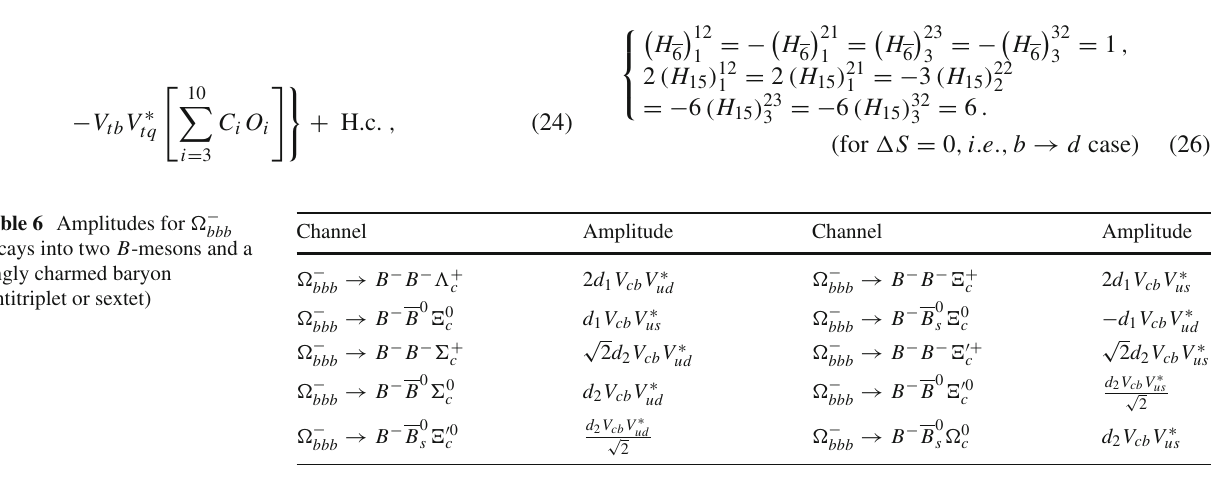
Fig. 5 Feynman diagrams for (cid:2) − singly charmed baryon (antitriplet or sextet)